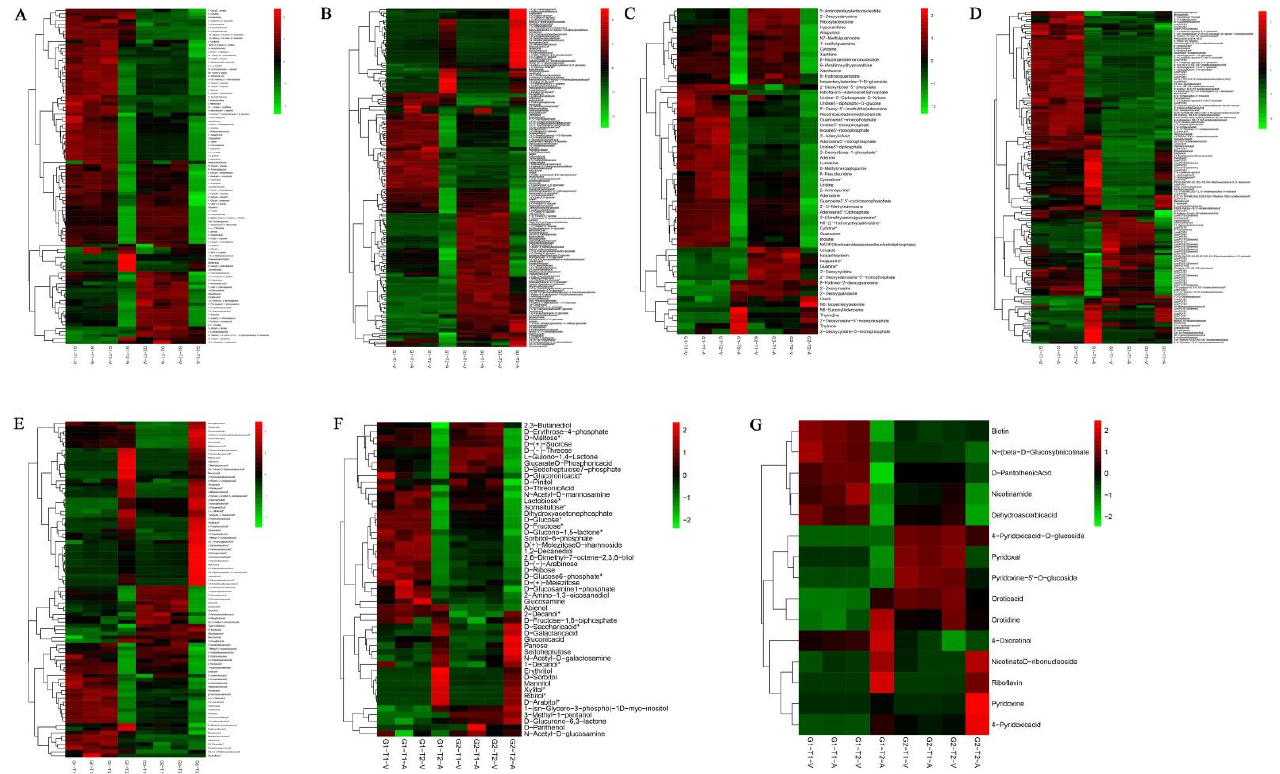
Figure 3. Heatmap of the primary metabolites in the different storage methods of G1 and G2: ( A ) 104